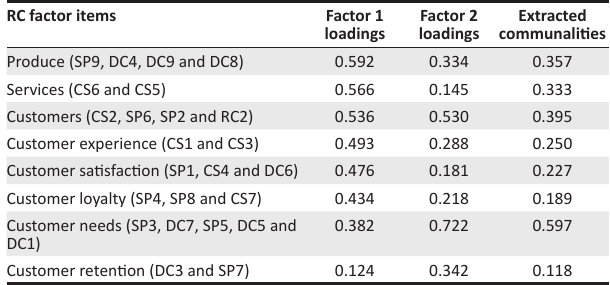
TABLE 10: Initial eigenvalues for relational capital disclosure (first-level factor